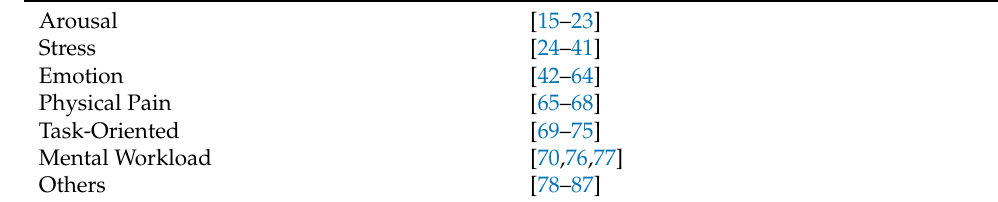
Table 1. Paper classification by group.